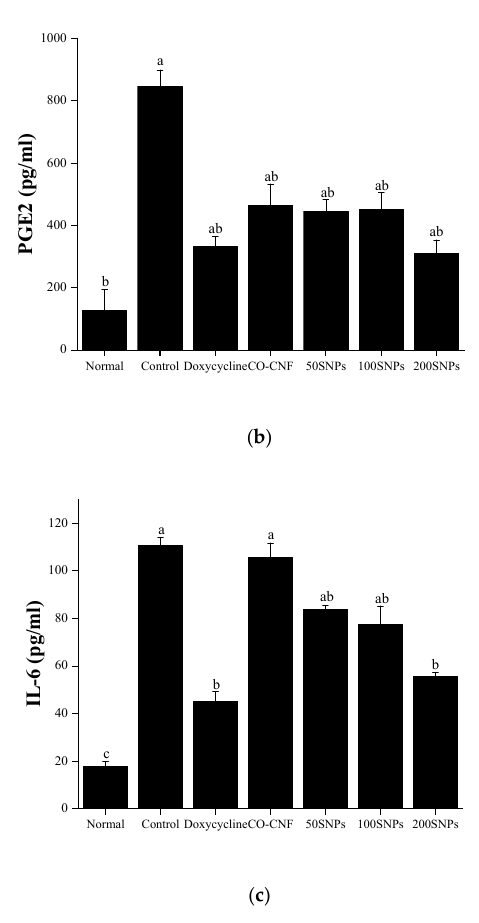
Figure 9. Level of ( a ) nuclear factor (NF)- κ B, ( b ) prostaglandin E2, and ( c ) interleukin-6 in nanoparti- cle treated lipopolysaccharide (LPS)-stimulated cells. The cells (1 × 10 4 cells/well) were pre-treated with 20 µ L of samples (50 µ g/mL) and 10 µ L of LPS (1 µ g/mL). Data are expressed as mean ± S.D. ( n = 3). The letters (a–c) indicated the significant differences of the groups at p < 0.05 analyzed by the Tukey test. Abbreviations: CO-CNF: κ -carrageenan oligosaccharides linked cellulose